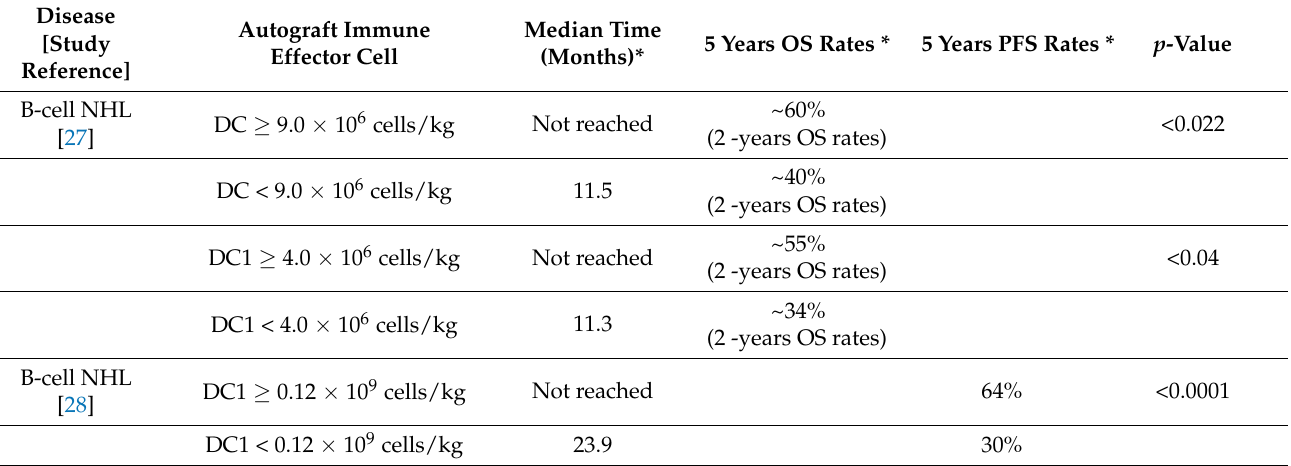
Table 2. Clinical outcomes post-autologous stem cell transplantation based on the infusion of autograft-professional antigen-presenting